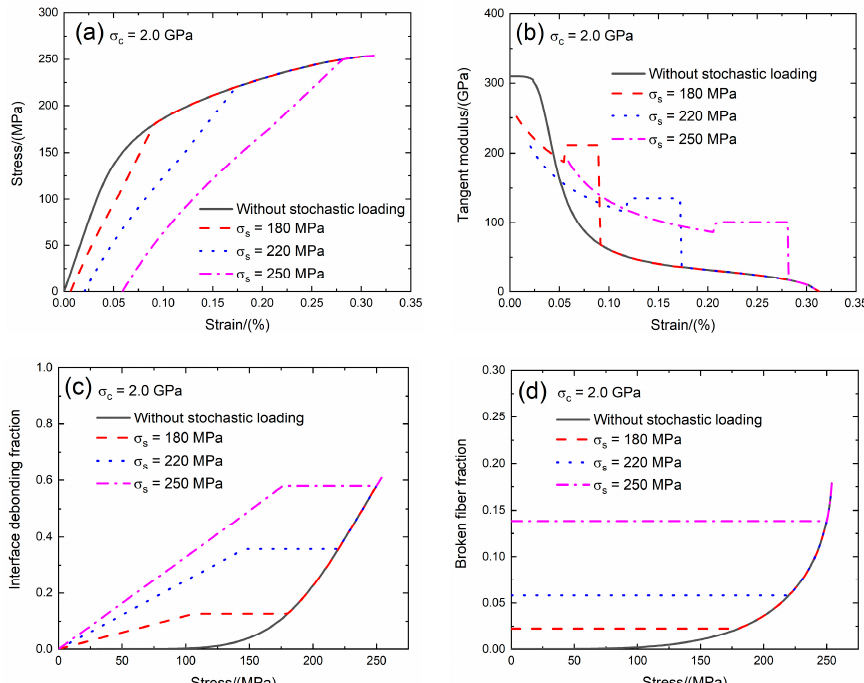
Figure 11. ( a ) The tensile stress–strain curves; ( b ) the tangent modulus versus strain curves; ( c ) the interface debonding fraction versus stress curves; and ( d ) the broken fibers fraction versus stress curves of SiC/SiC composite for conditions without stochastic loading and with stochastic loading of σ s = 180, 220 and 250 MPa when σ c = 2.0 GPa.